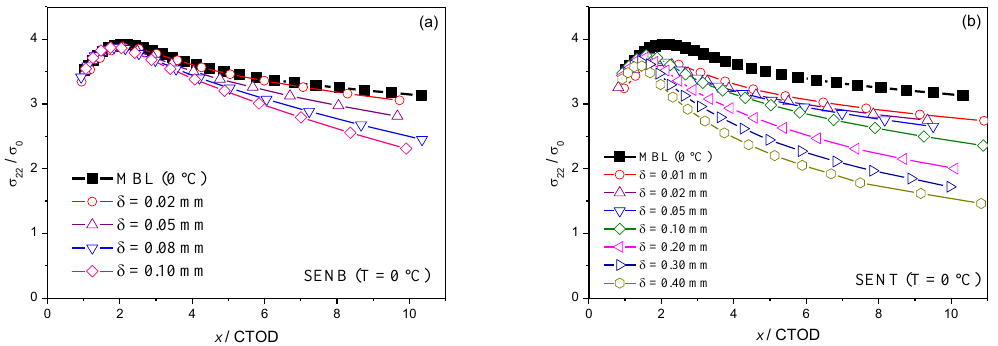
Figure 8. Opening stress distributions ahead of the crack tip, T = 0 °C. ( a ) SENB; ( b ) SENT.